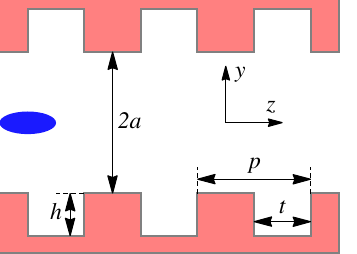
FIG. 1. Three corrugations of a vertical dechirper. A rectangular coordinate system is centered on the symmetry axis of the chamber. The blue ellipse represents an electron beam propa- gating along the z axis.